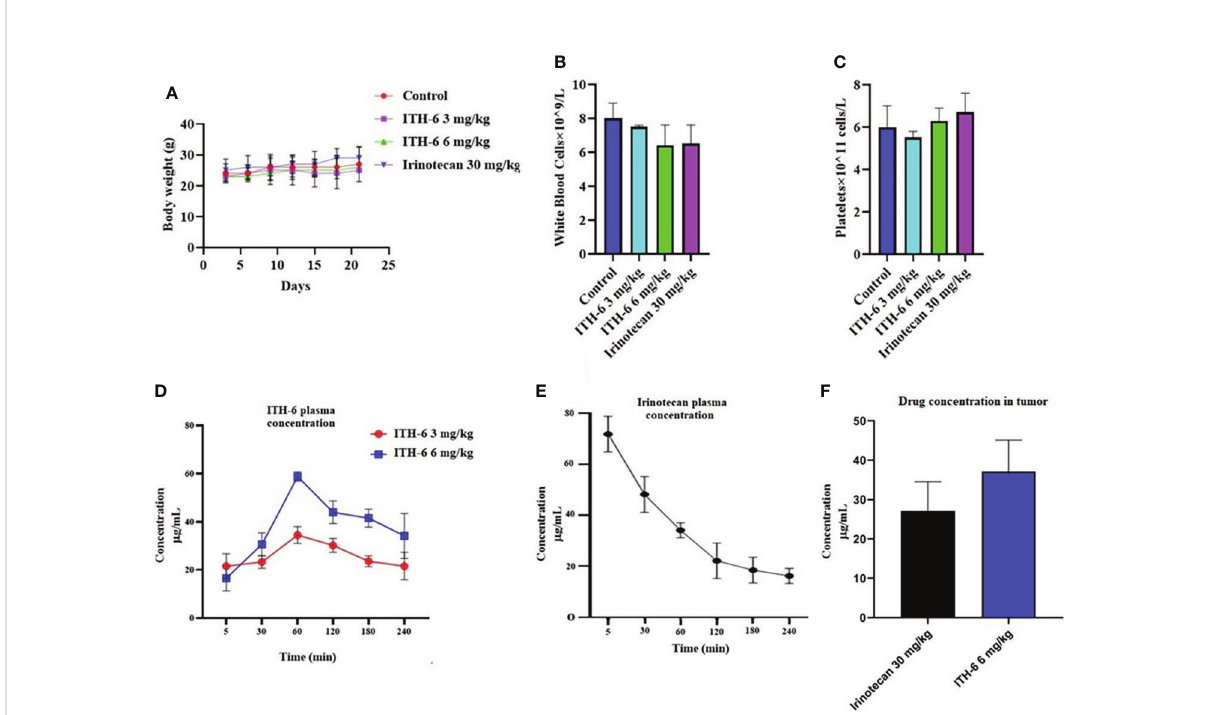
FIGURE 9 (A) Changes in mean body weight before and after treatment for xenograft model are shown. (B) The changes in mean white blood cells in nude mice ( n = 6) at the end of the 21-day treatment period and (C) the changes in mean platelets in nude mice ( n = 6) at the end of the 21- day treatment period. Plasma concentrations of (D) ITH-6 and (E) irinotecan in nude athymic mice at 5, 30, 60, 120, 180, and 240 minutes following administration of ITH-6 (3 and 6 mg/kg) given orally and irinotecan (30 mg/kg) given intraperitoneally. (F) Intratumoral concentrations of irinotecan and ITH-6 in KM 12 ( n = 6) and HT-29 tumors ( n = 6) following administration of these drugs. Points with error bars represent the mean ±